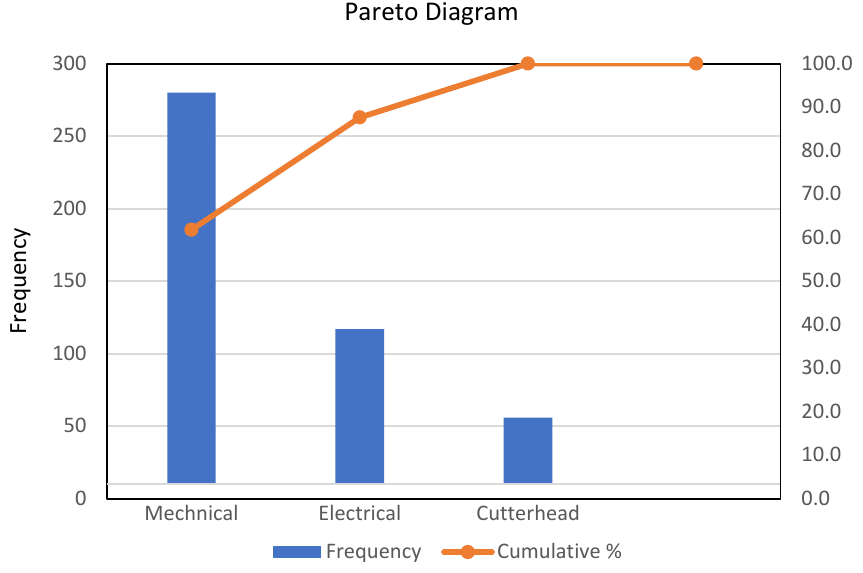
Figure 9. Pareto analysis of EPBM subsystems in Line 1.